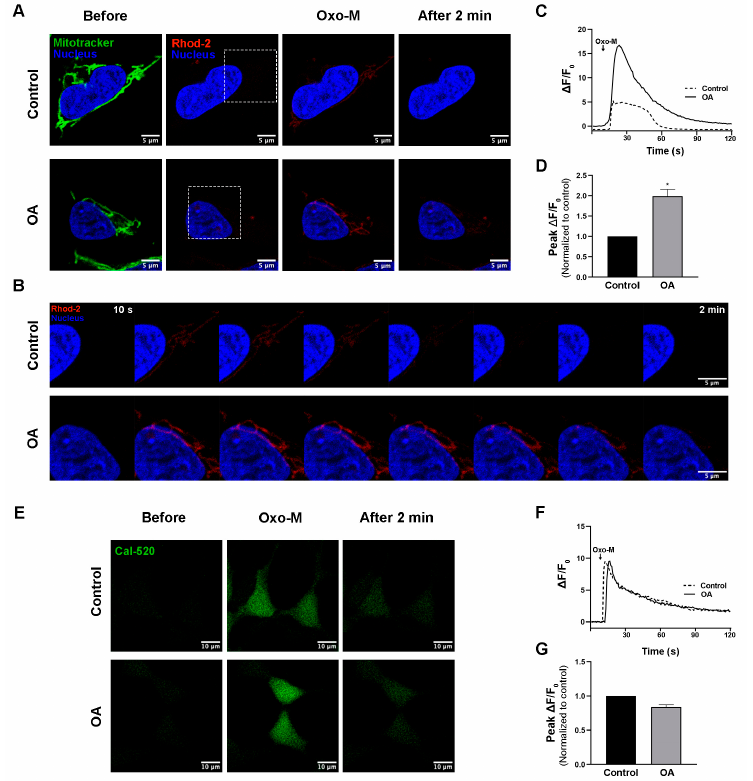
Figure 2. Effects of PP2A inhibition on mitochondrial Ca 2+ in SH-SY5Y cells. ( A ) Representative time-lapse images of control and okadaic acid-treated cells loaded with Mitotracker and Rhod-2 fluorescence dye. The images were captured at 880 ms intervals and show the cells before, at peak intensity, and 2 min after Oxo-M stimulation. ( B ) Magnified images from the white boxes in ( A ) showing 10 s interval time lapses. ( C ) Plots of Rhod-2 fluorescence intensity from ( A ) are shown as ∆ F/F 0 vs. time (s). ( D ) Bar graph representing the peak value of ∆ F/F 0 normalized with the control. ( E ) Representative images of Cal-520 fluorescence in the cells before, at peak intensity, and 2 min after Oxo-M stimulation. ( F ) Plots of Cal-520 fluorescence intensity from ( E ) are shown as ∆ F/F 0 vs. time (s). ( G ) Bar graph representing the fluorescence intensity of the peak value of ∆ F/F 0 normalized with the control. Data represent means ± SEMs of four independent experiments for mitochondrial Ca 2+ levels and of three independent experiments for cytosol Ca 2+ levels. * p < 0.05 (Student’s t -test). Scale bars are 5 μ m and 10 μ m. 3.3. PP2A Inhibition Decreased Mitochondrial Membrane Potential and Mitochondrial Fission Healthy and functioning mitochondria establish and maintain specific membrane po- tentials, which can be observed by TMRM, a cell-permeant dye that accumulates in active mitochondria with intact membrane potentials. Mitochondrial Ca 2+ overloading has been